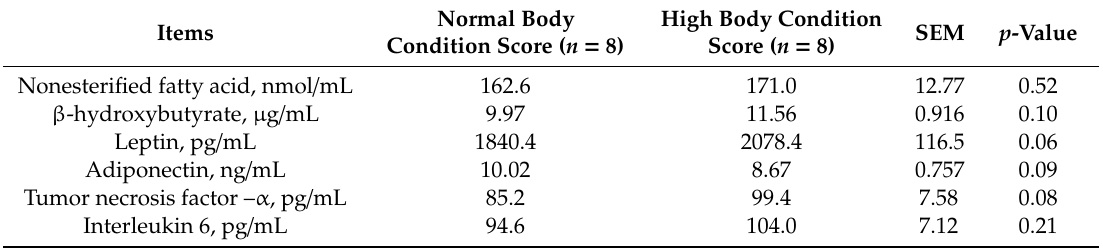
Table 1. Classical metabolic parameters of plasma of cows with di ff erent calving body condition score. Normal Body High Body Condition SEM p -Value Items Condition Score ( n = 8) Score ( n = 8) Nonesterified fatty acid, nmol / mL